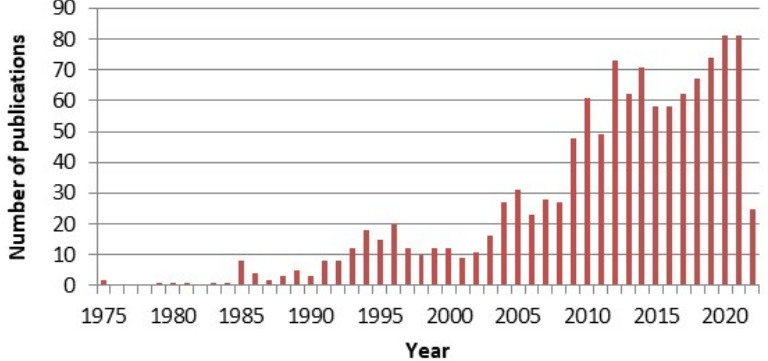
Figure 2. The number of publications during the period 1975–2020.